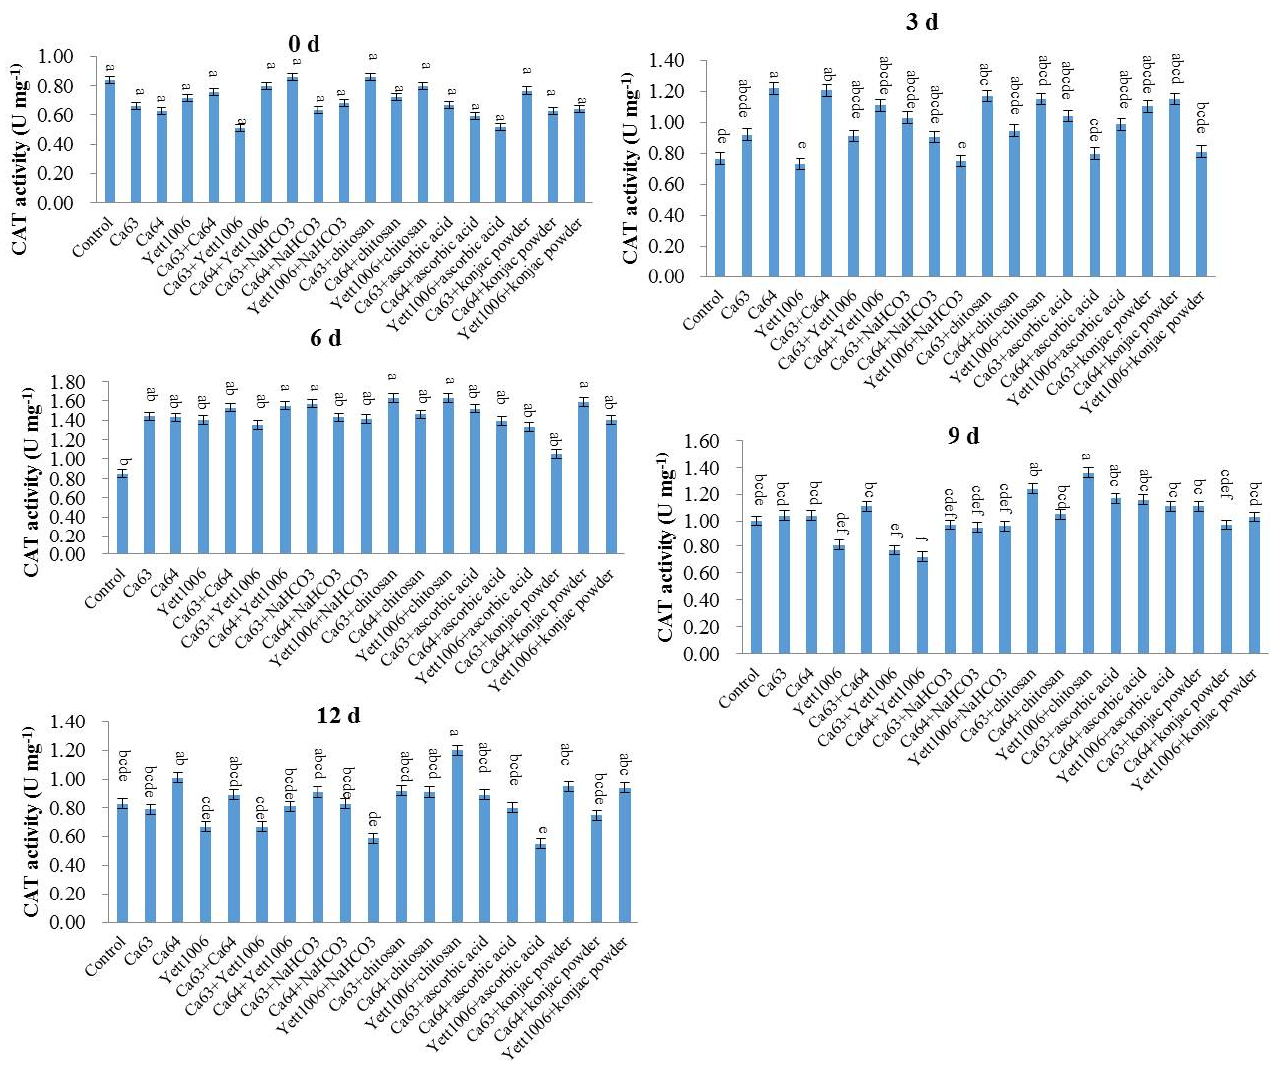
Figure 12. Evaluation of CAT activity in snap beans between different treatments. Error bars represent the standard deviations of means ( n = 3). On the bars, the small letters indicate a significant difference in the treatment according to Duncan’s multiple difference test ( p < 0.05).